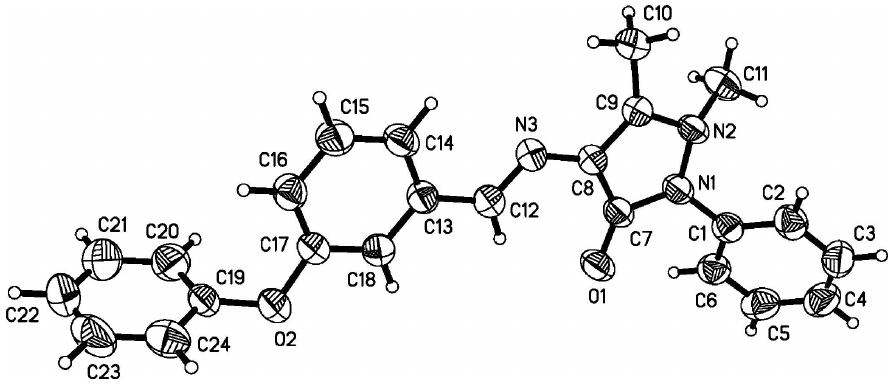
Figure 1 View of the molecule of (I) showing the atom-labelling scheme. Displacement ellipsoids are drawn at the 50% probability level. H atoms are shown as small spheres of arbitrary